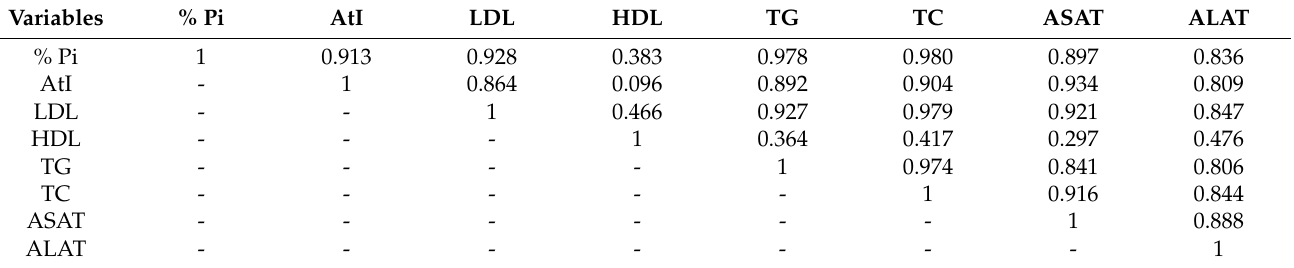
Table 4. PCA Pearson correlation matrix of measured parameters: % Pi, biochemical parameters (TG, TC, HDL, LDL, AtI), ASAT and ALAT levels.